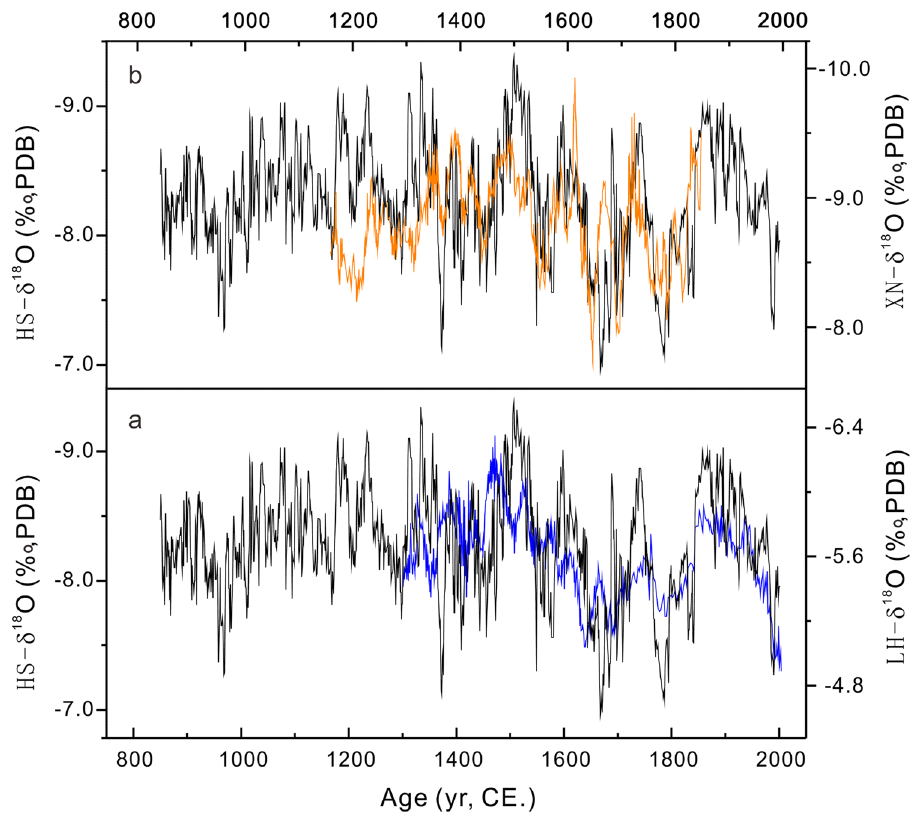
Fig. 3 High-resolved δ 18 O comparisons between HS4 and other stalagmites from Central China. a HS4 in this study and LH from Lianhua cave, Hunan 38 (blue curve). b HS4 and XN from Xiuniu cave, Hubei 39 (orange curve). The HS4 annual δ 18 O record duplicates other high-resolution speleothem records from nearby caves in recent centuries, suggesting the HS4 record could represent the stalagmite δ 18 O variation in Central China.